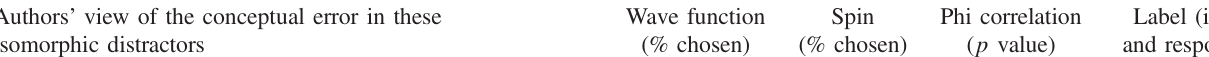
TABLE II. Statistically significant partial correlations at the p < 0 . 05 level between commonly selected ( > 10% ) incorrect responses on paired questions. Labels refers to the module identification in Fig. 3. If no label is provided the pairing does not appear as a module in the MMA-P analysis Fig. 3. Question numbers refer to QMCA version 6.2.2 with the letter indicating the answer option. Authors ’ view of the conceptual error in